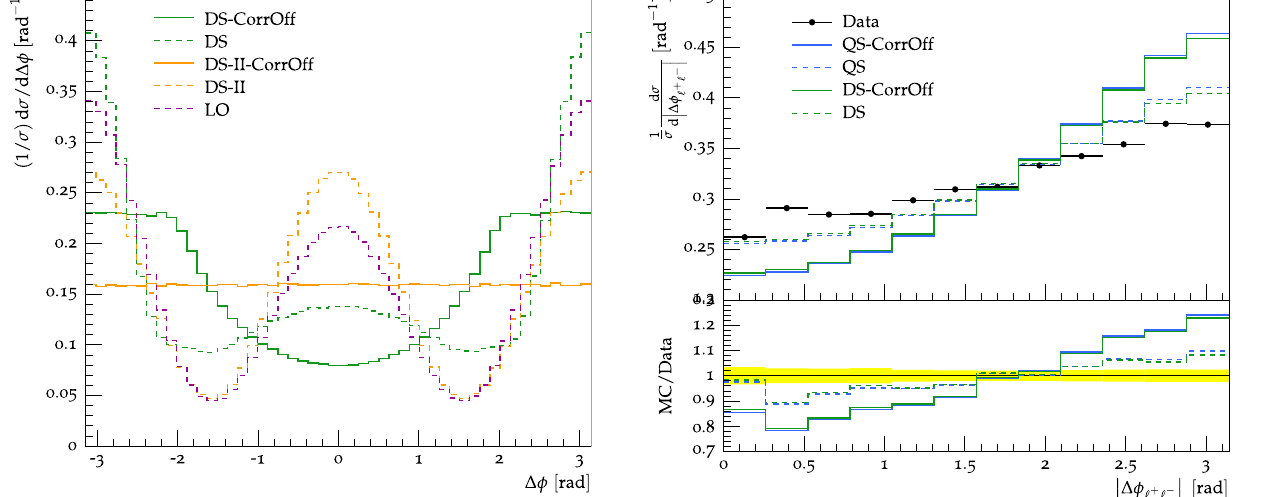
Fig. 6 The azimuthal separation of the charged leptons in 8 TeV dilep- tonic pp → t ¯ t events,asmeasuredbyCMS[32]andpredictedusingthe angular-ordered (QS) and dipole (DS) parton showers in Herwig 7. The predictions of the angular-ordered (QS-CorrOff) shower and the dipole